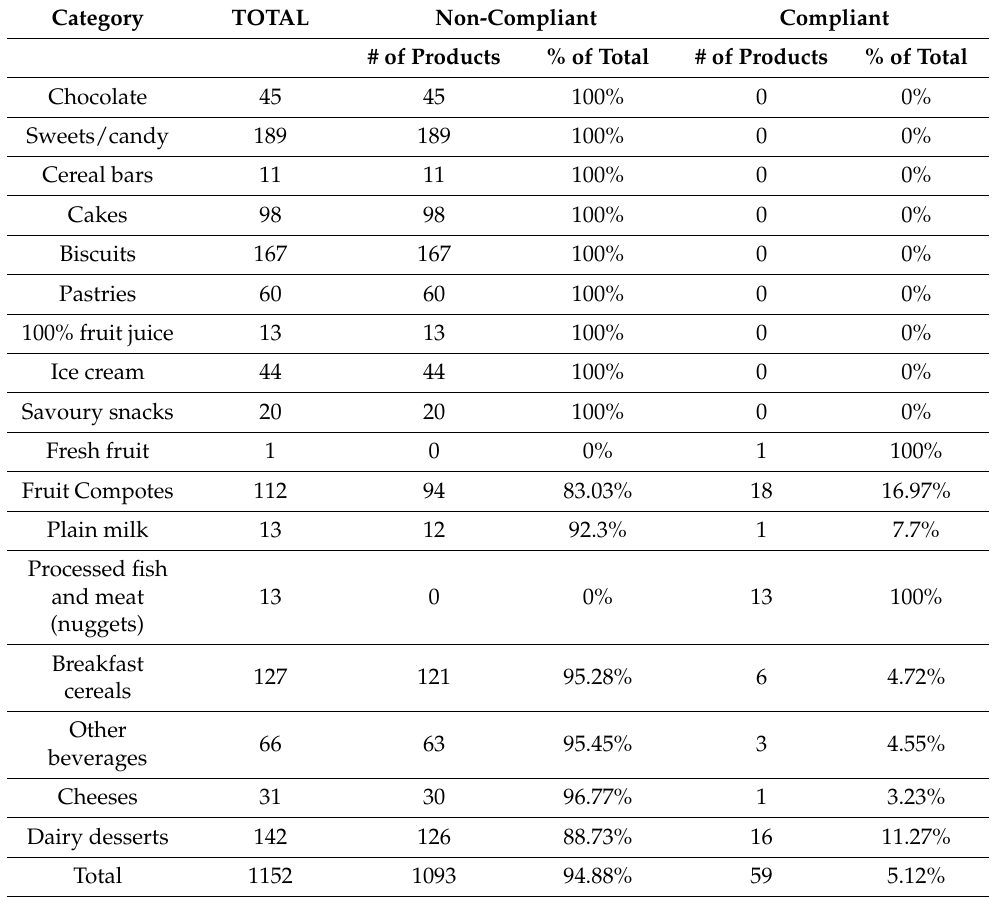
Table 4. Overview of compliance with the criteria of the WHO Europe Nutrient Profile Model [15] by food